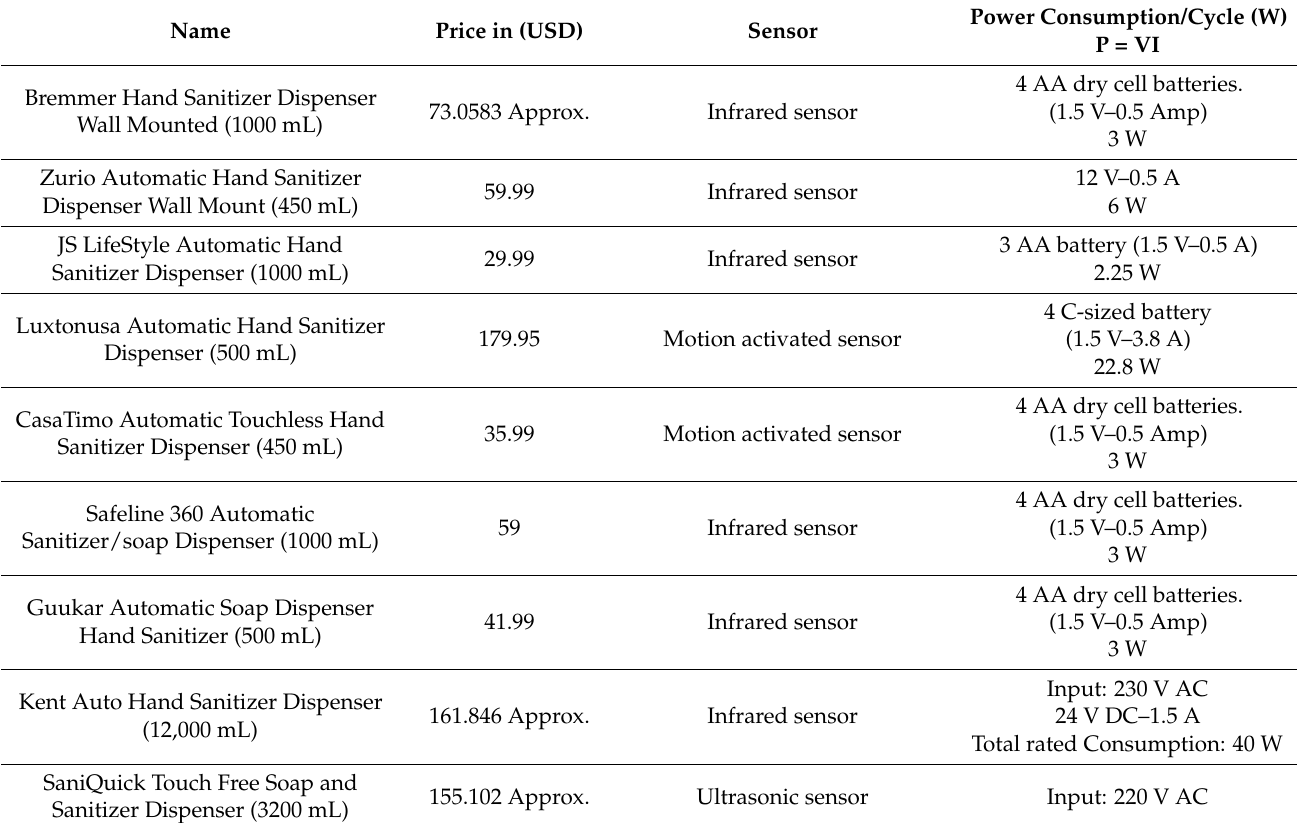
Table 5. Available dispenser devices name sensor power